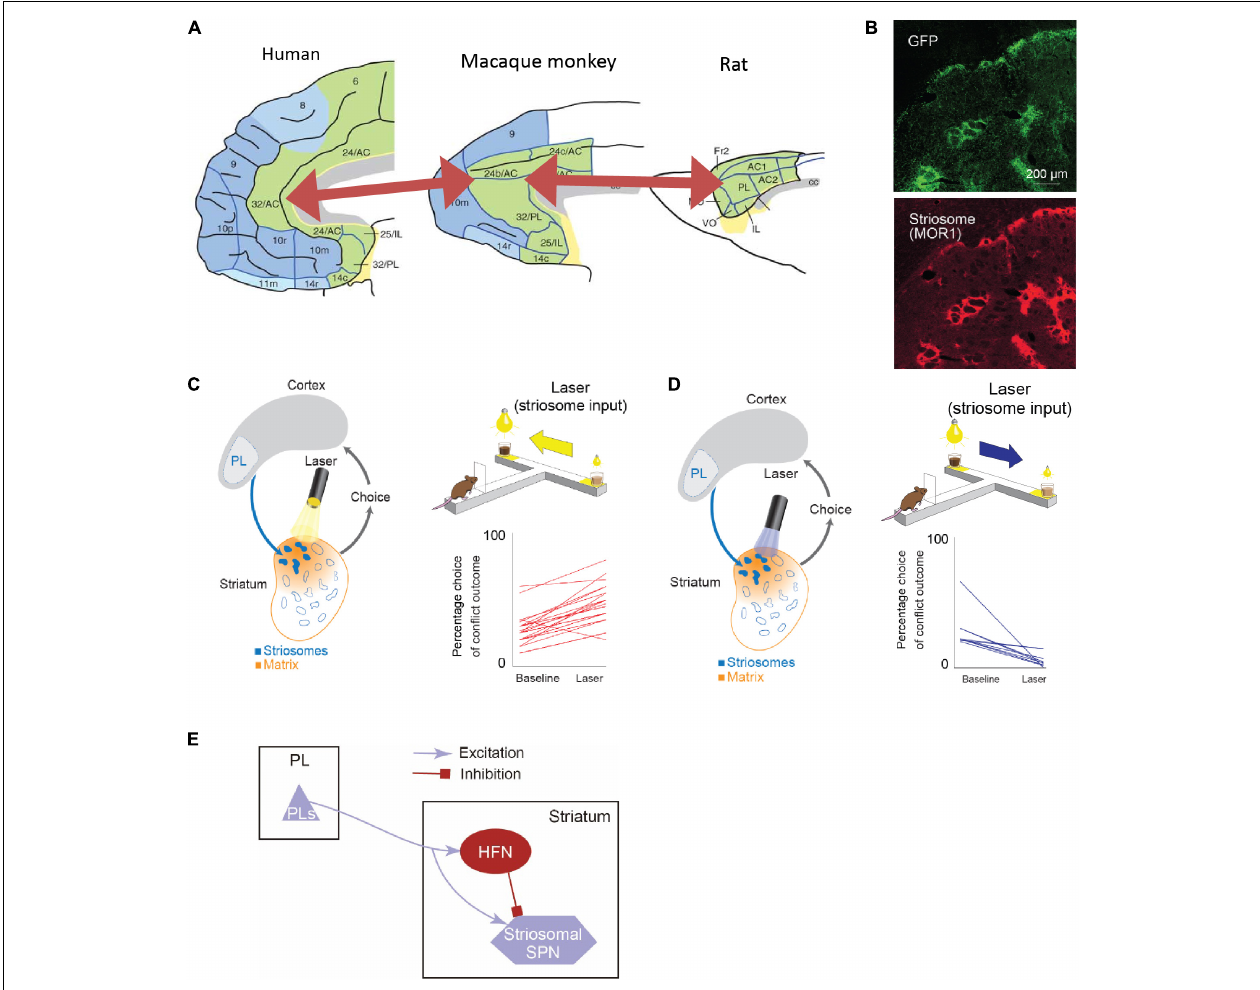
FIGURE 5 | The rodent PL-striosomal pathway is causally involved in pessimistic decision-making (Adapted from Friedman et al., 2015). (A) Comparison of human, macaque, and rat limbic cortices. In the macaque areas 24/32 and rat prelimbic cortex (PL), the projection to striosomes is predominant. The macaque areas 24/32 are considered to be homologous to the human areas 24/32 (Adapted from Wise, 2008). (B) GFP-labeled rat PL striatal projections (top) and striosomes identified by MOR staining (bottom). (C) Pathway-selective inhibition of PFC-PL-striosomal pathway by halorhodopsin increased selection of chocolate milk under strong light (high-cost, high-reward option). (D) Pathway-selective excitation of PFC-PL-striosomal pathway by channelrhodopsin increased selection of diluted chocolate milk under dim light. (E) Schematic diagram of PFC-PL-striosomal circuit. In conflict task, optogenetic inhibition of the PFC-PL pathway (C) released activity in the striosomes via the inhibition of HFNs during the time when the animals greatly increased their approaches to high-cost, high-reward goals. By contrast, optogenetic excitation of this pathway (D) tuned off striosomes via the activation of HFNs during the time when the animals decreased their approaches to such